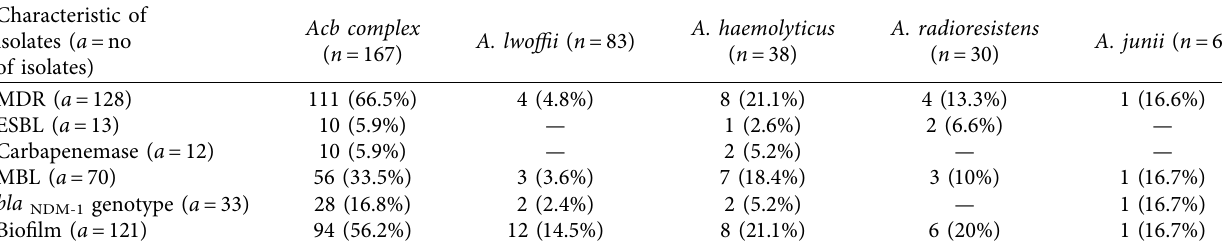
Table 3: Acinetobacter species in relation to various types of resistance mechanisms and bioflm formation. Characteristic